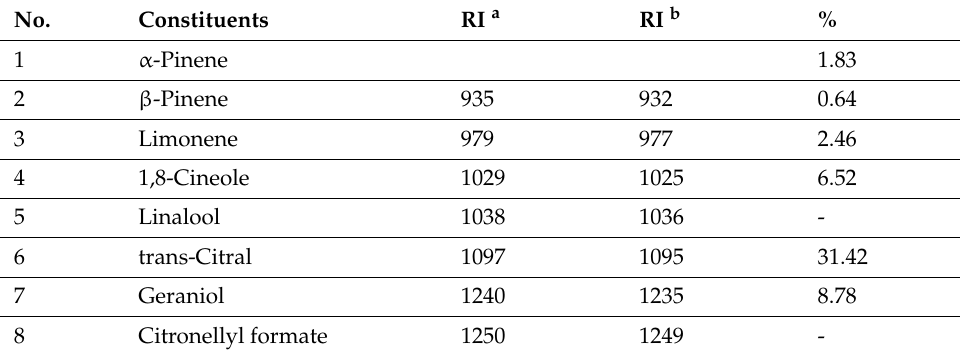
Table 1. Chemical composition of lemongrass